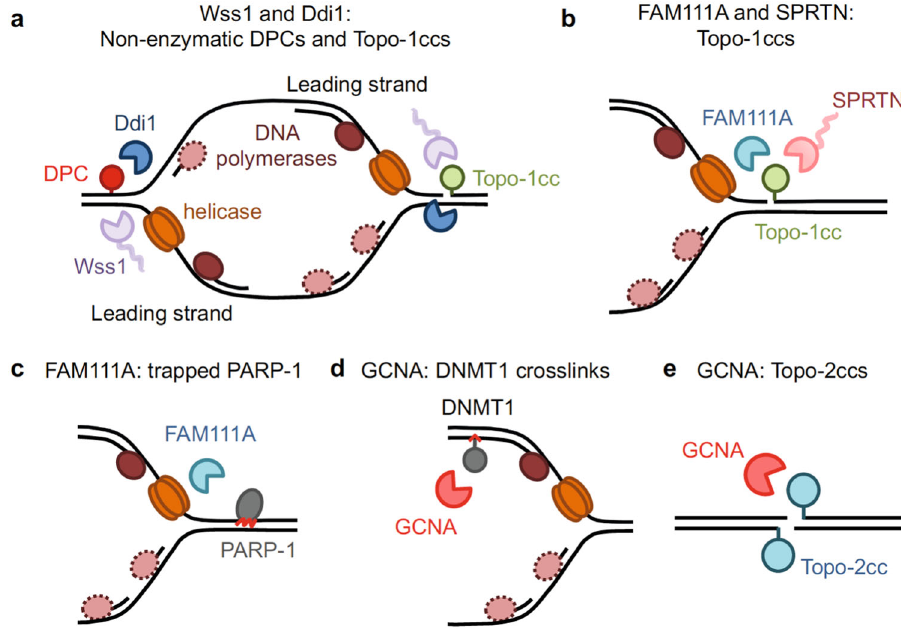
Fig. 3 Overlapping and non-overlapping functions of DPC proteases. a Wss1 and Ddi1 are both required for the repair of non-enzymatic DPCs and Topo- 1ccs during replication. b FAM111A and SPRTN have both been implicated in Topo-1cc resolution, based on CPT resistance. c Sensitivity to PARP-1 inhibitors and DNA combing assays suggest that FAM111A, but not SPRTN, is involved in the resolution of trapped PARP-1. d Human GCNA resolves DNMT1 crosslinks at 5-azadC incorporation sites (red arrowhead), behind the replication fork. e GCNA resolves Topo-2ccs in fl ies, worms and zebra fi